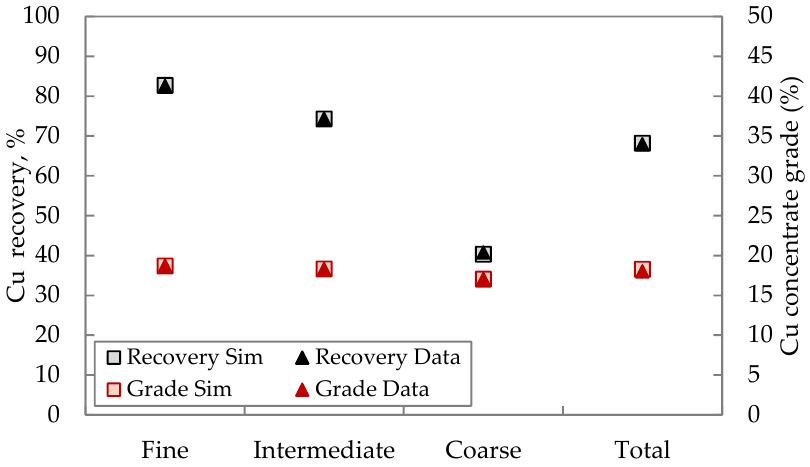
Figure 3. Comparison between measured and simulated data after calibration: Cu recovery and concentrate grade.